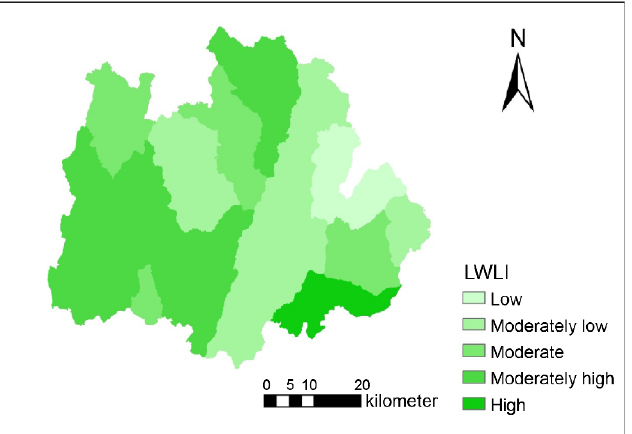
Figure 7. Location-weighted landscape contrast index (LWLCI) zoning of Qixia.